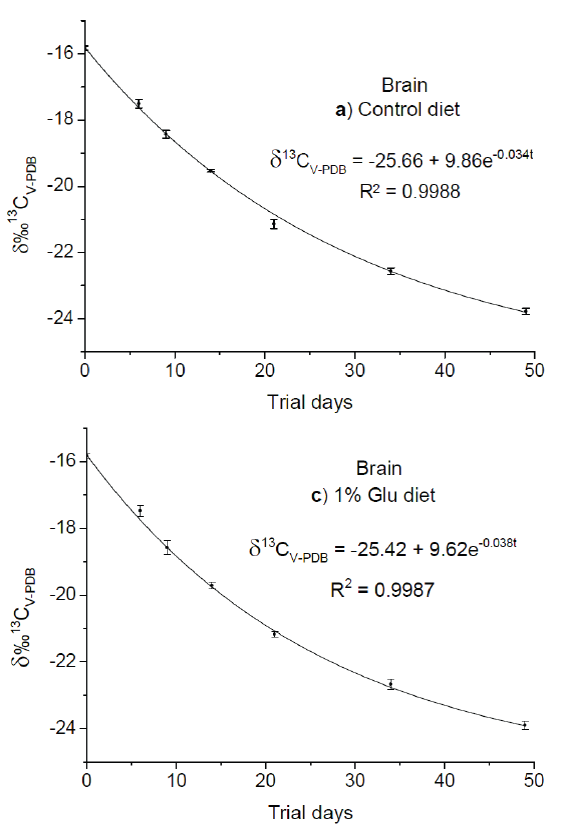
Figure 1 - Non-linear adjustment of exponential curves (δ‰ 13 C 1% glutamic acid, and ( d ): 0.1% nucleotides + 1% glutamic acid. Values expressed as: mean (n = 3) ± standard